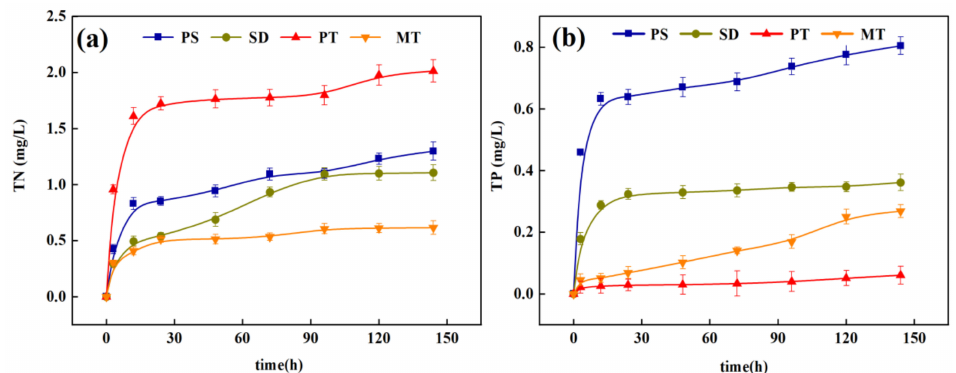
Figure 3. Release of total nitrogen (TN) and total phosphorus (TP) of different carbon sources; ( a ) TN; ( b ) TP.